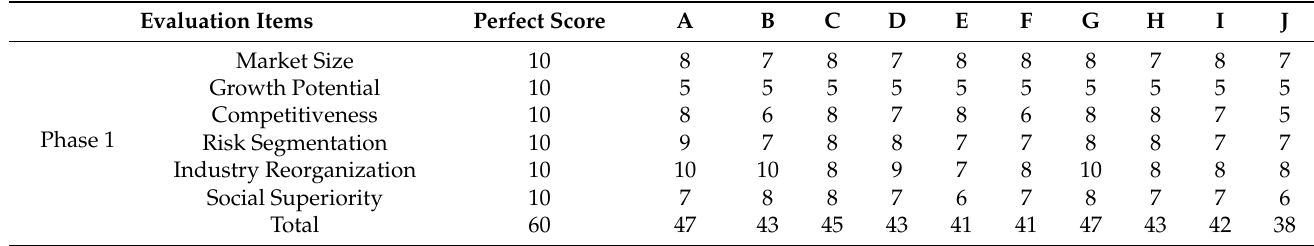
Table 2. BMO evaluation